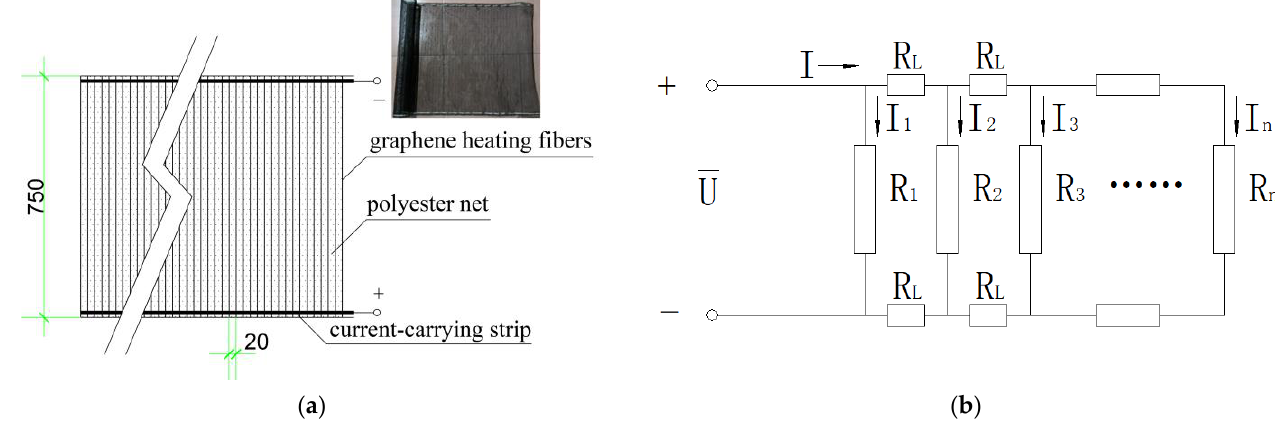
Figure 5. The structure ( a ) and principle ( b ) of the electrothermal film.